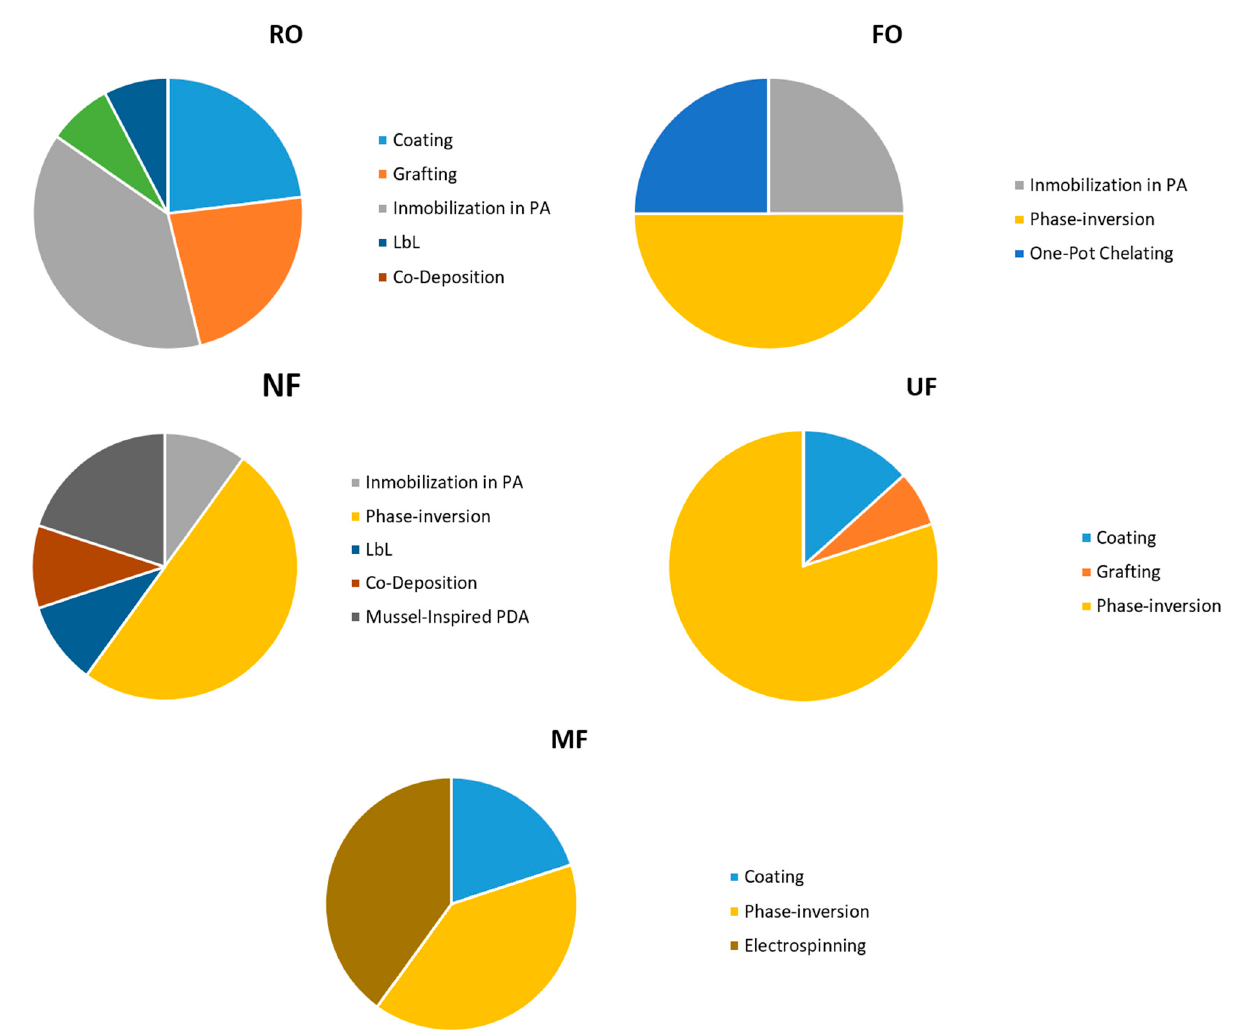
Figure 2. Distribution of the different techniques used for modified membranes with copper. The diagrams are plotted using the data presented in articles [14,27,28,32,36,40,42–79,81–87].